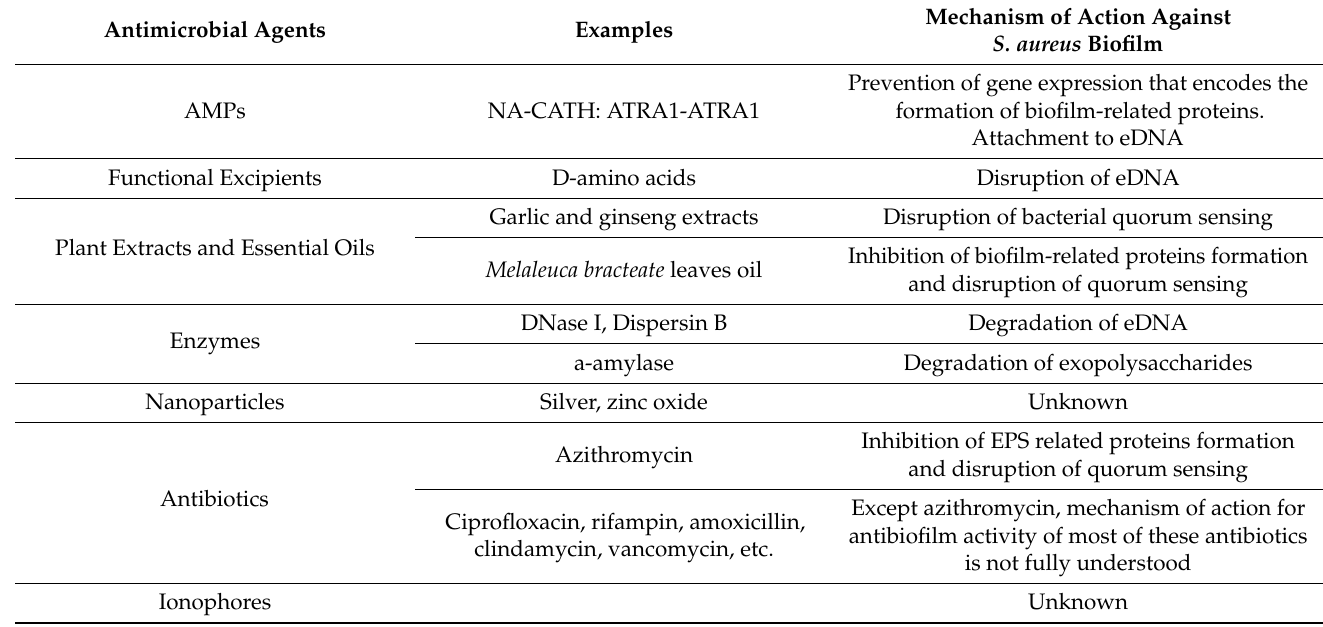
Mechanism of Action